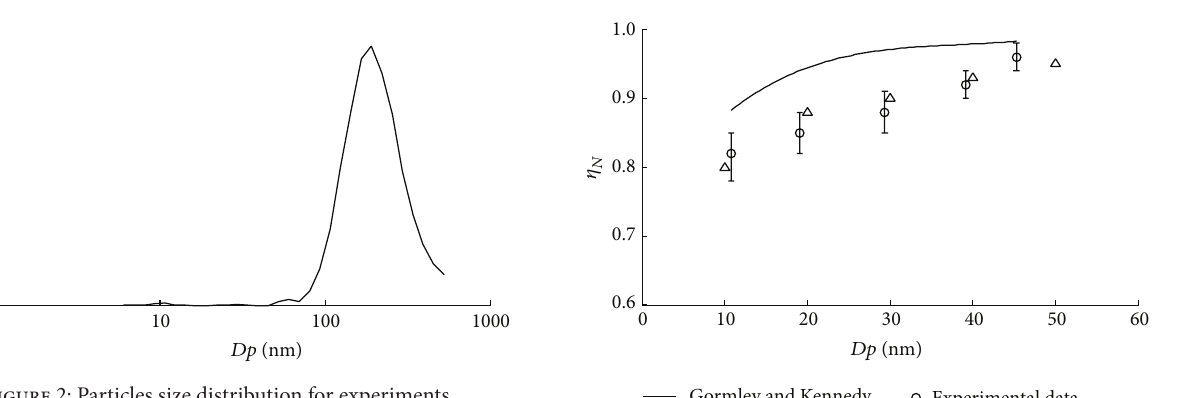
Figure 2: Particles size distribution for experiments.